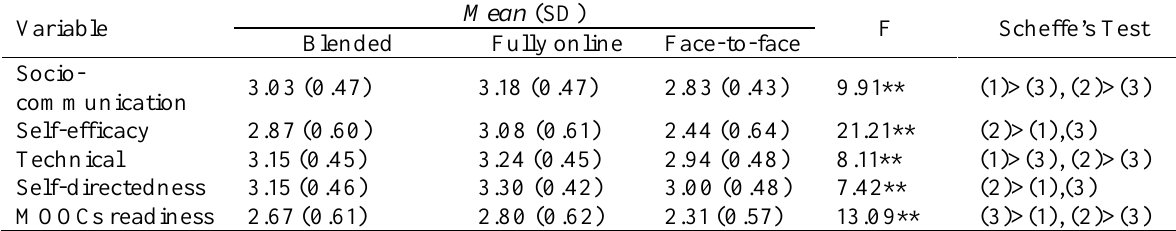
Descriptive Statistics and F-test of Mode of Delivery on MOOCs Readiness Dimensions